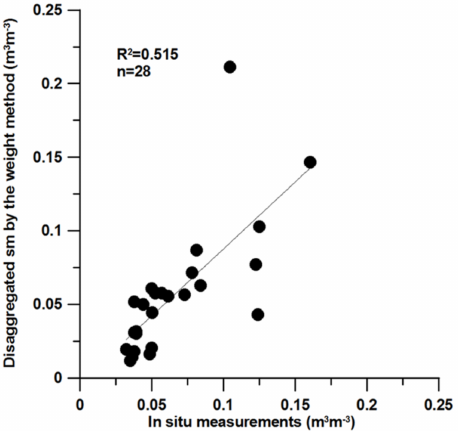
Figure 6. Evaluation of disaggregated soil moisture products by the weight method against the in situ